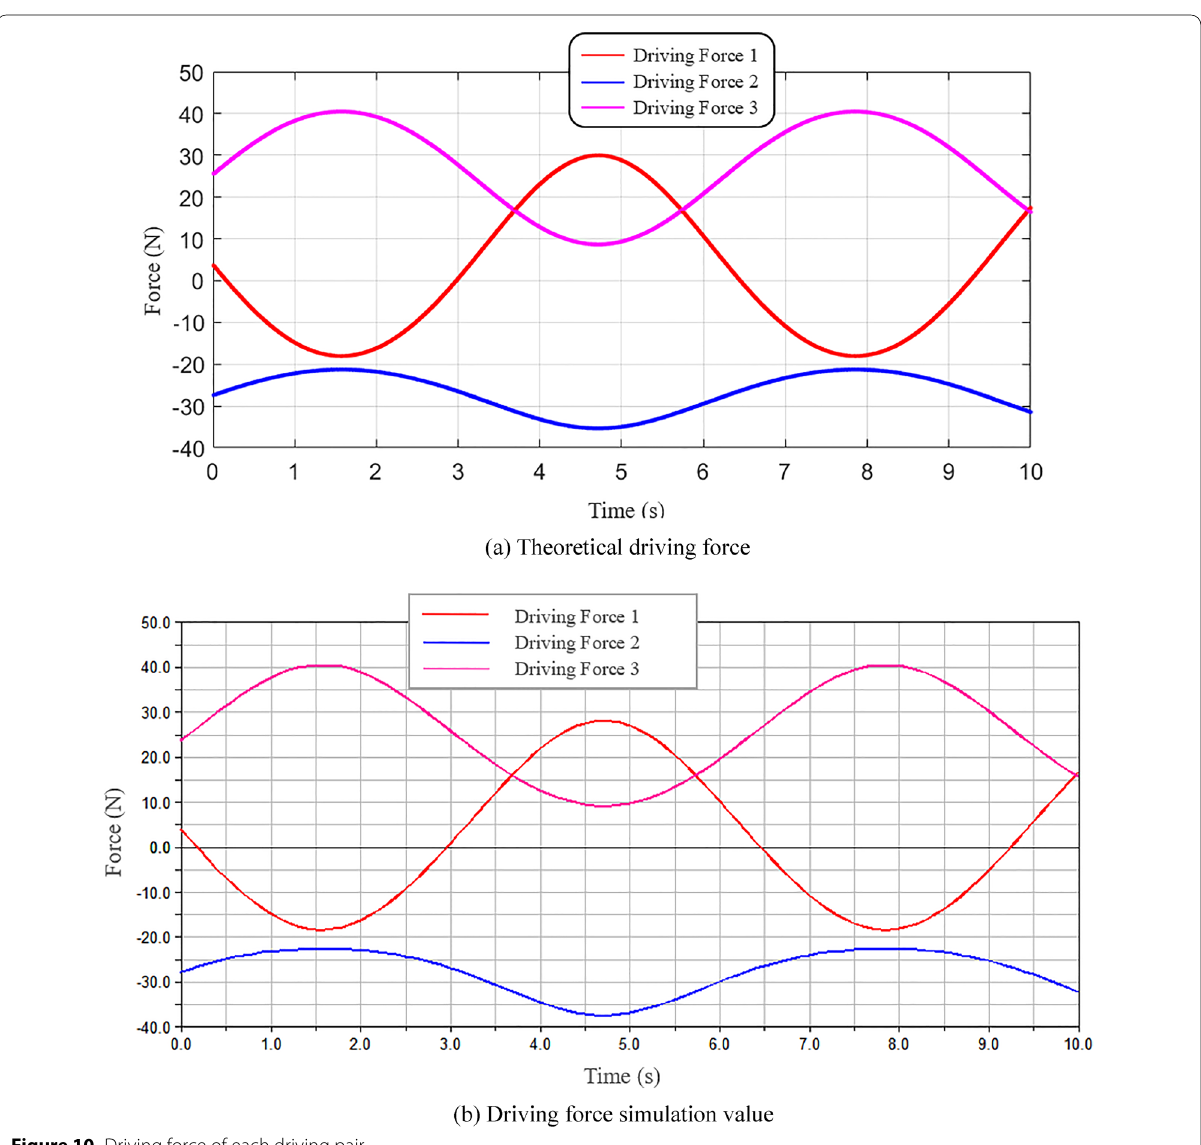
Figure 10 Driving force of each driving